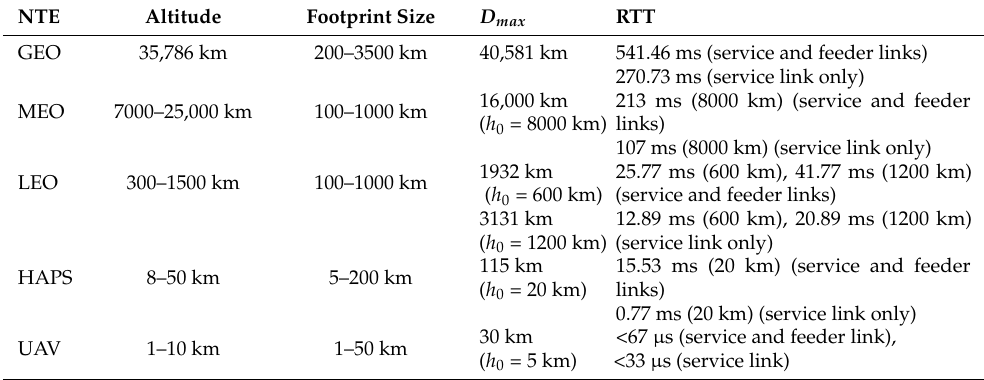
Table 1. Parameters for NTN types and scenarios [2,27].